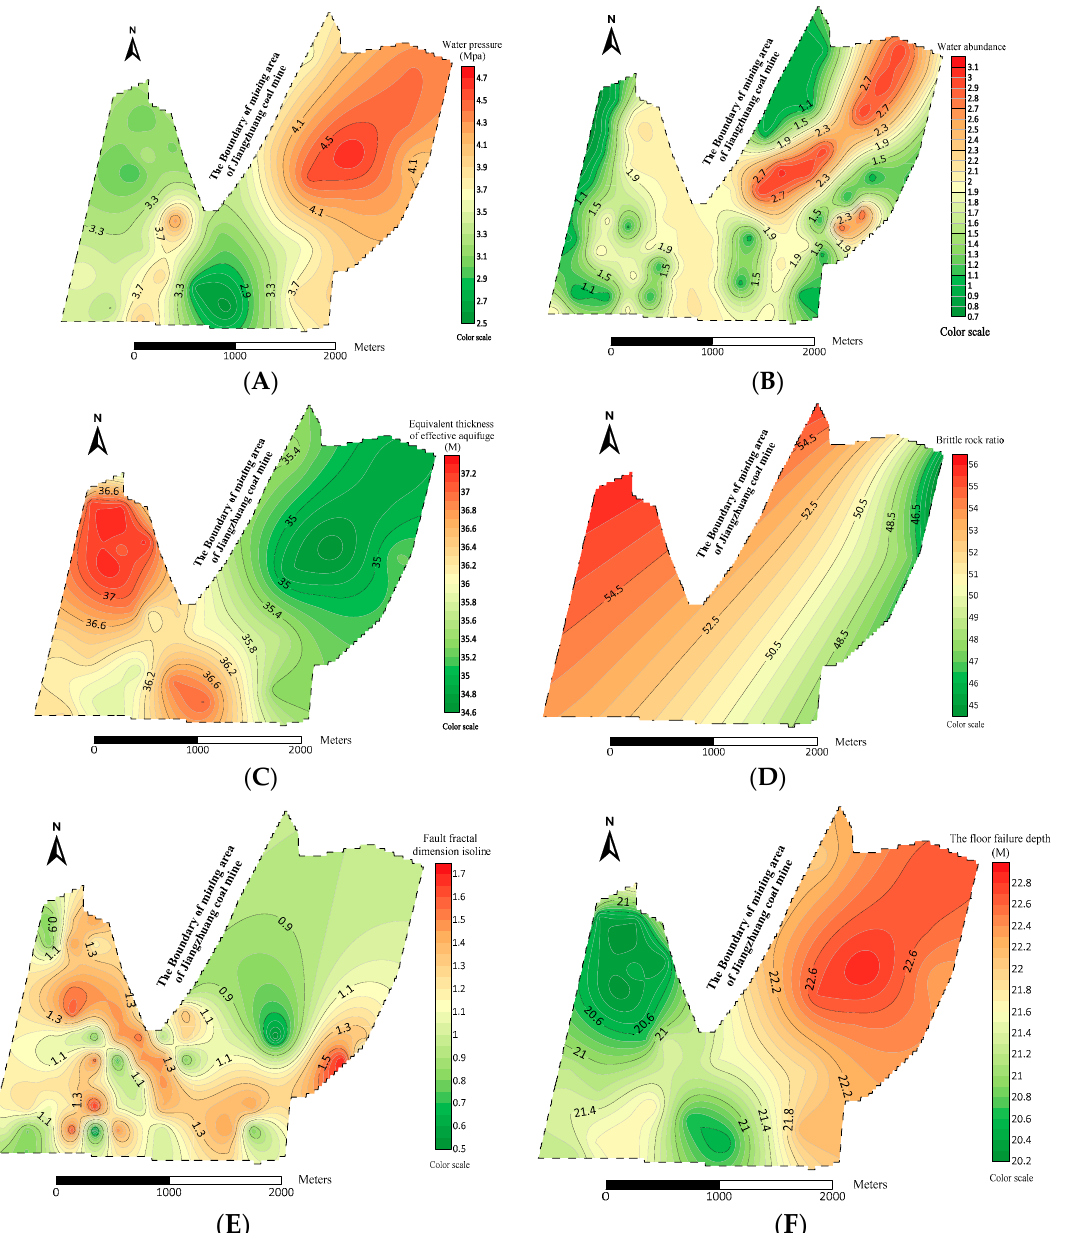
Figure 3. Schematic map of water inrush influencing factors of the coal seam floor isoline in the 162 and 163 mining areas. ( A ) Water pressure of the Ordovician limestone aquifer isoline, ( B )Water abundance of the Ordovician limestone aquifer isoline, ( C ) Equivalent thickness of effective aquifuge isoline, ( D ) Brittle rock ratio isoline, ( E ) Fracture structure dimension isoline, ( F ) Floor Failure Depth Isoline.